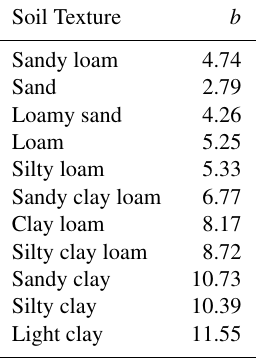
Table 2. Soil texture and EF5/CREST b parameter value as derived from Cosby et al.